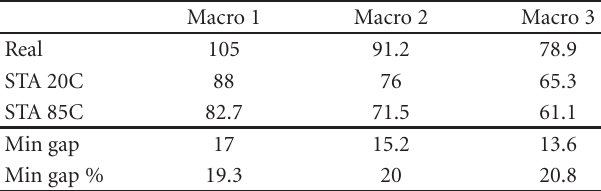
Table 1: OSC macrofrequency (MHz).